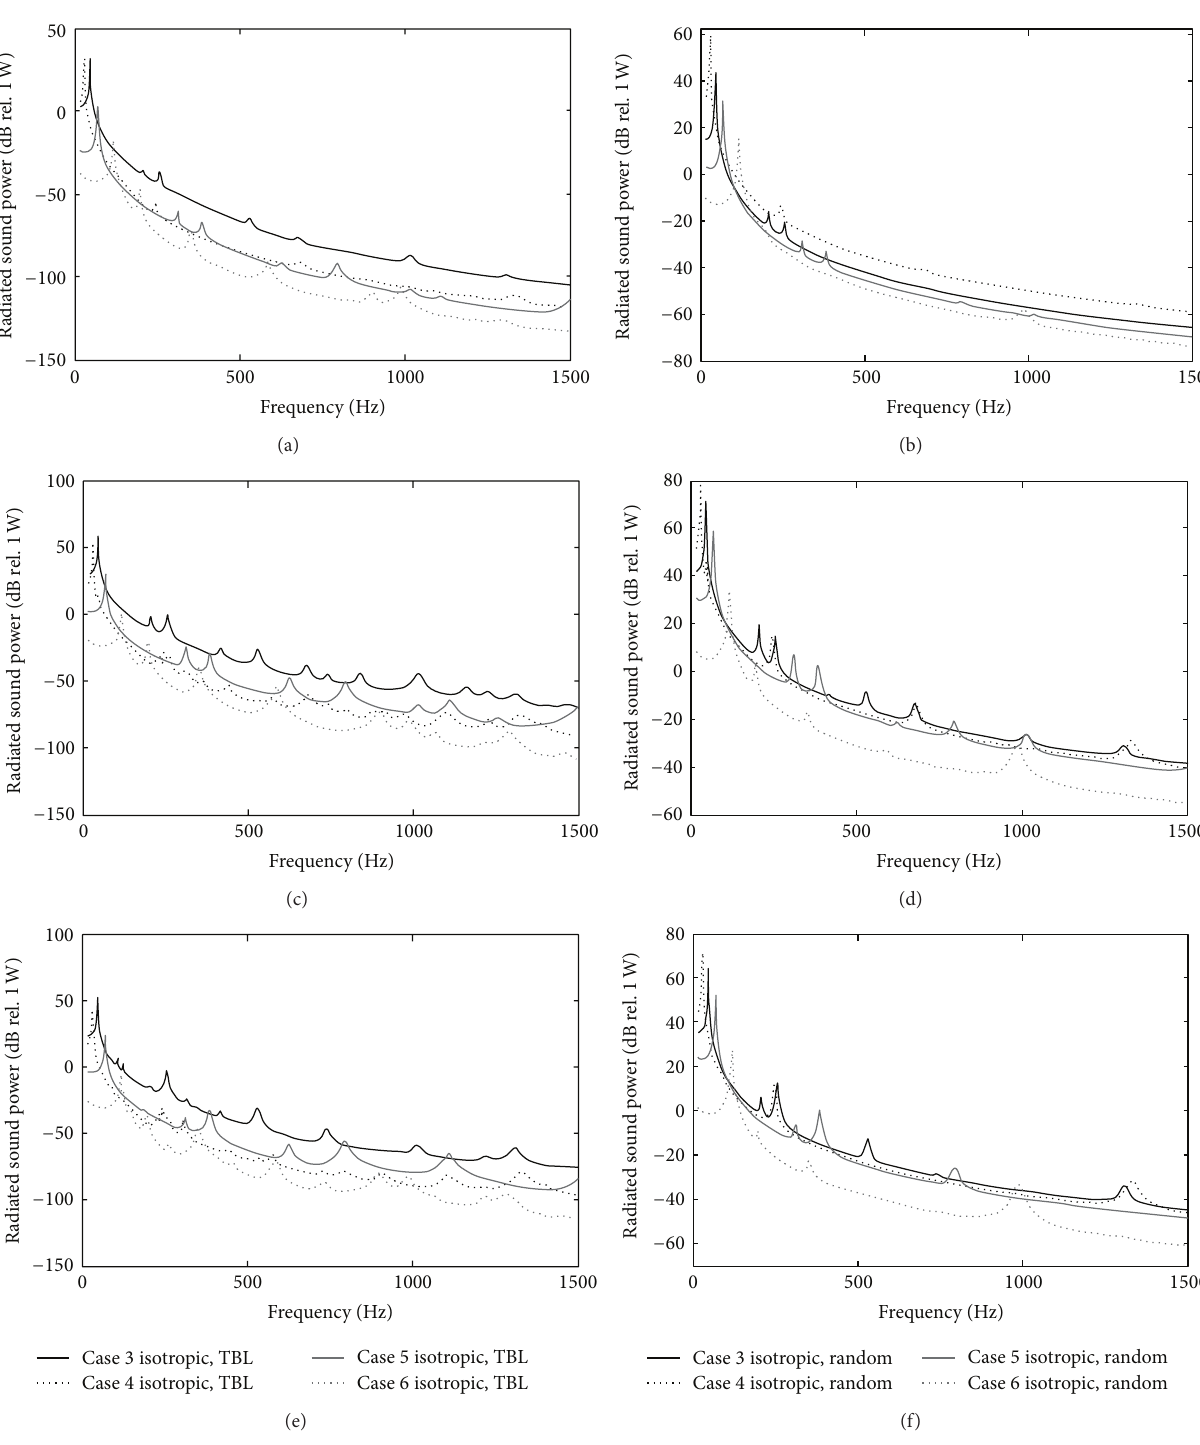
, 𝑦 ) = (0.3𝑎, 0.2𝑏) 2 2